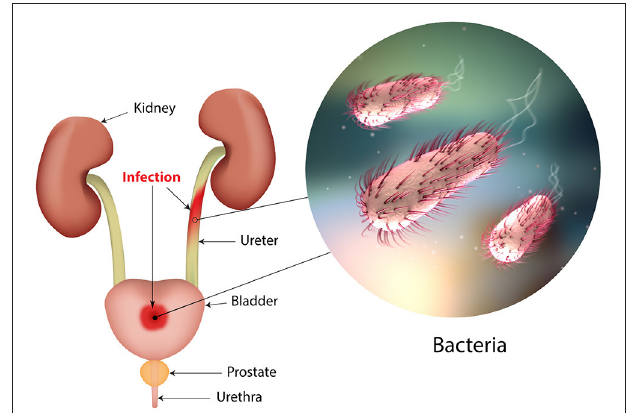
FIGURE 1 | The urinary tract and sites of infection.